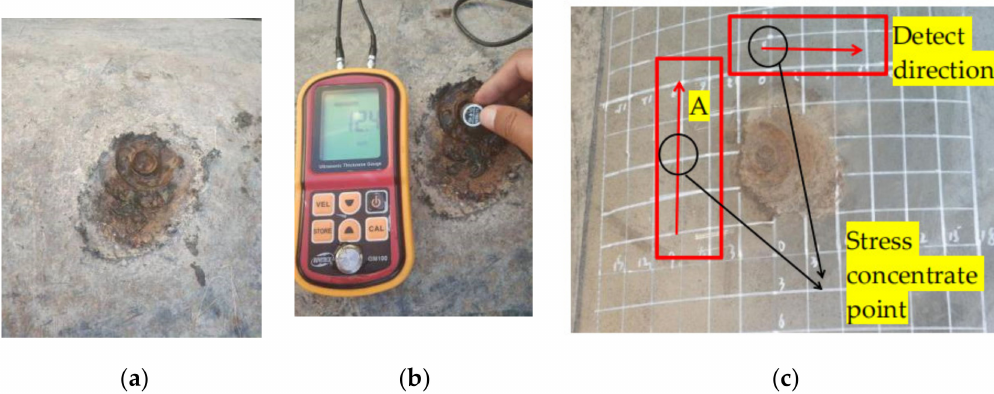
Figure 22. The excavation verification results: ( a ) Damage of anticorrosion coating; ( b ) Ultrasonic thickness measurement; ( c ) Pipe wall damage.